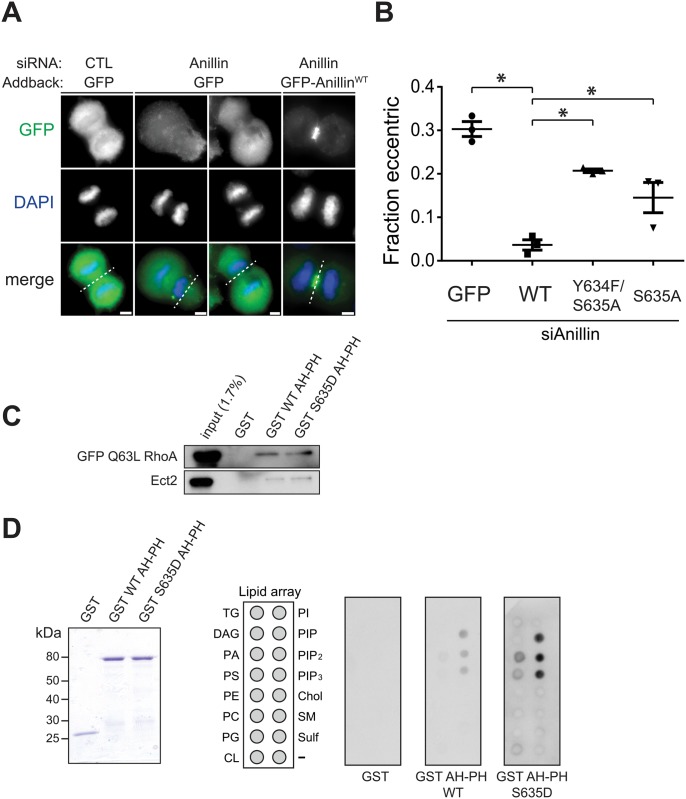
Ser635A anillin exhibits a destabilized furrow, and phosphomimetic does not alter binding to Ect2, RhoA, or selectivity for specific phospholipids.(A) Knockdown/addback revealed eccentric furrows seen in anaphase cells after depletion of anillin. Dashed line marks approximate region of furrow. Scale bar, 5 μm. (B) Asynchronous Hela cells were treated by knockdown/addback and analyzed for furrow location at 48 hours. Fraction of eccentric furrows was quantified in anaphase and telophase cells (n = 3; ≥50 cells per condition). *ANOVA detected differences between wild-type rescue and other conditions. (C) Western blot analysis of pulled down RhoA and Ect2 with GST AH-PH anillin. HeLa extracts from transfected with GFP Q63L RhoA (top panel) or untransfected (bottom) were used in pull-down assays with wild-type or phosphomimetic S635 GST AH-PH. (D) Coomassie blue staining of recombinant GST and GST AH-PH anillin (left panel). GST fusion proteins were expressed in E. coli and purified using Glutathione Sepharose 4B Fast Flow. Lipid arrays (middle panel) were incubated with the indicated recombinant proteins before being probed by anti-GST (right panel). Key for lipid array: TG = triglyceride; DAG = diacylglycerol; PA = phosphatidyl acid; PS = phosphatidylserine; PE = phosphatidylethanolamide, PC = phosphatidylcholine; PG = phosphatidylglycerol; CL = cardiolipin; PI = phosphatidylinositol; PIP = PI 4-phosphate; PIP2 = PI 4,5-bisphosphate; PIP3 = PI 3,4,5-triphosphate; Chol = cholesterol; SM = sphingomyelin; Sulf: sulfatide; - = Blank.